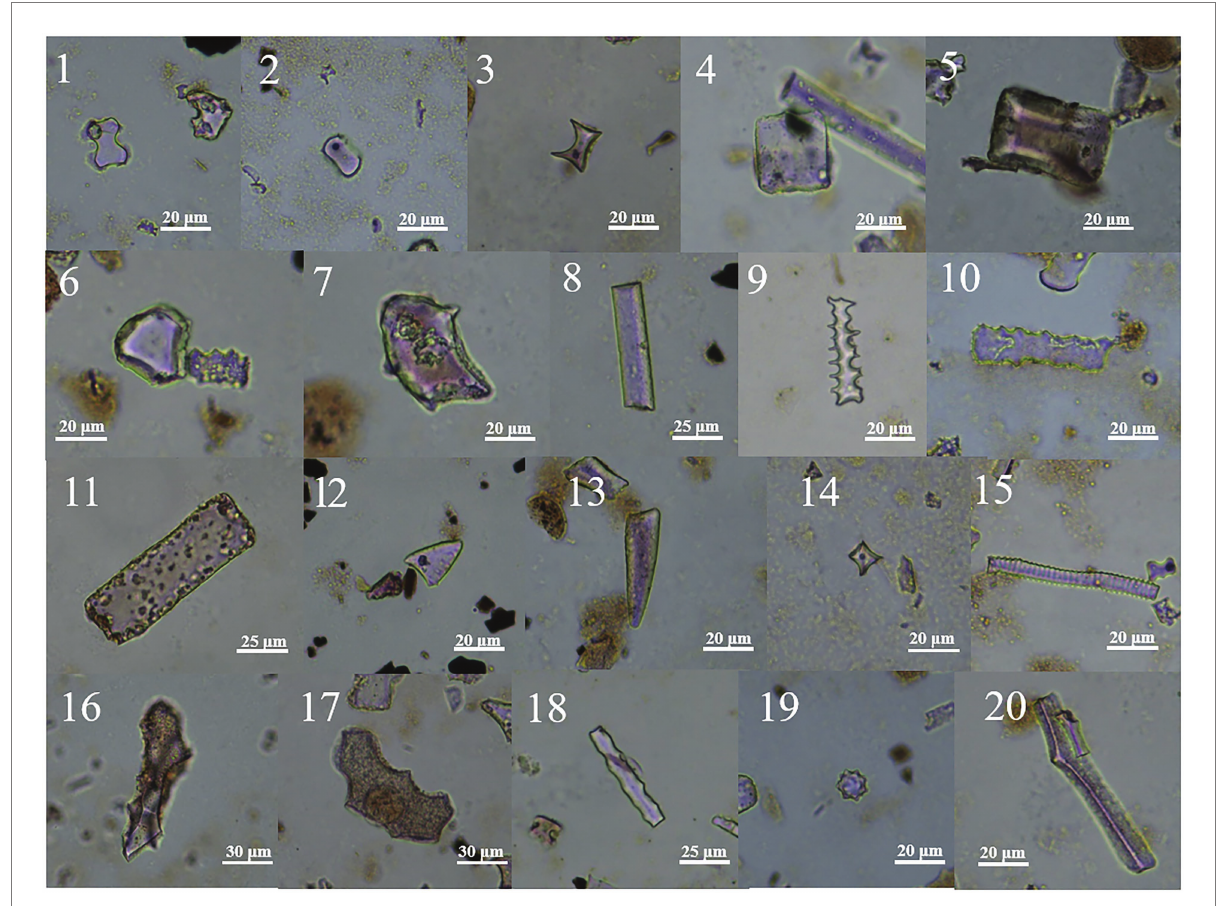
FIGURE 3 Diagnosis morphotypes of phytoliths in surface soil 1. Bilobate 2, 3. Collapsed saddle 4. Square 5. Rectangle 6. Bulliform flabellate 7. Bamb bulliform flabellate 8. Smooth-elongate 9. Thorn-elongate 10. Sinuate-elongate 11. Board-elongate 12. Short point 13. Long point 14. Tower 15. Tracheid 16. Net- spindle 17. Abbreviated stellate 18. Woody-elongate 19. Spheroid echinate (small) 20. Pteridophyte type.